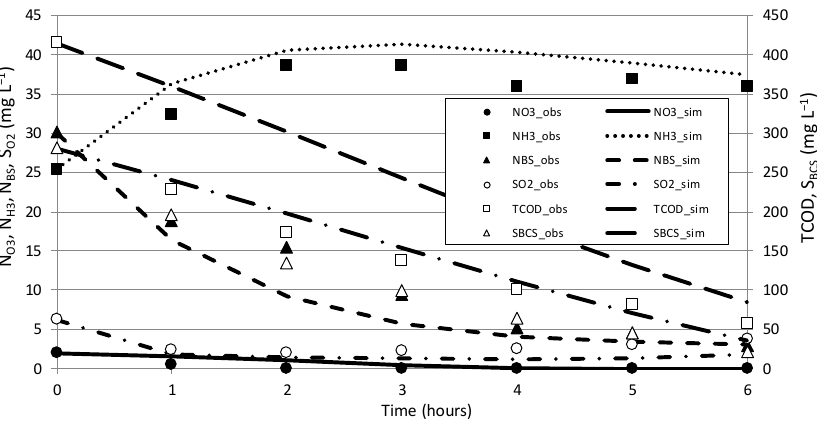
Figure 3. The OVs of different compounds.